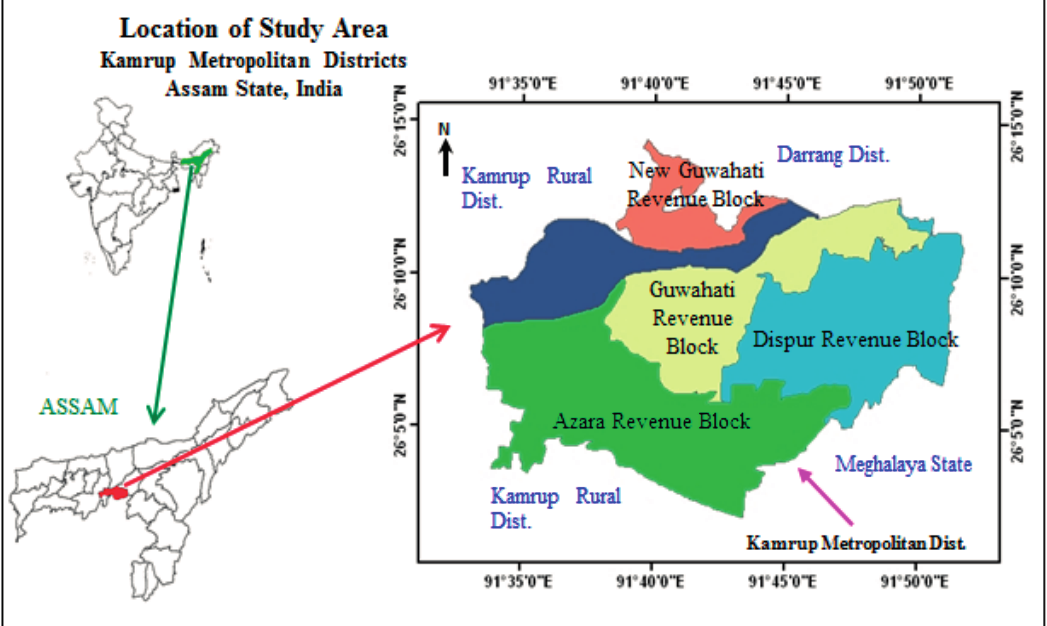
Figure 1. Location of study area